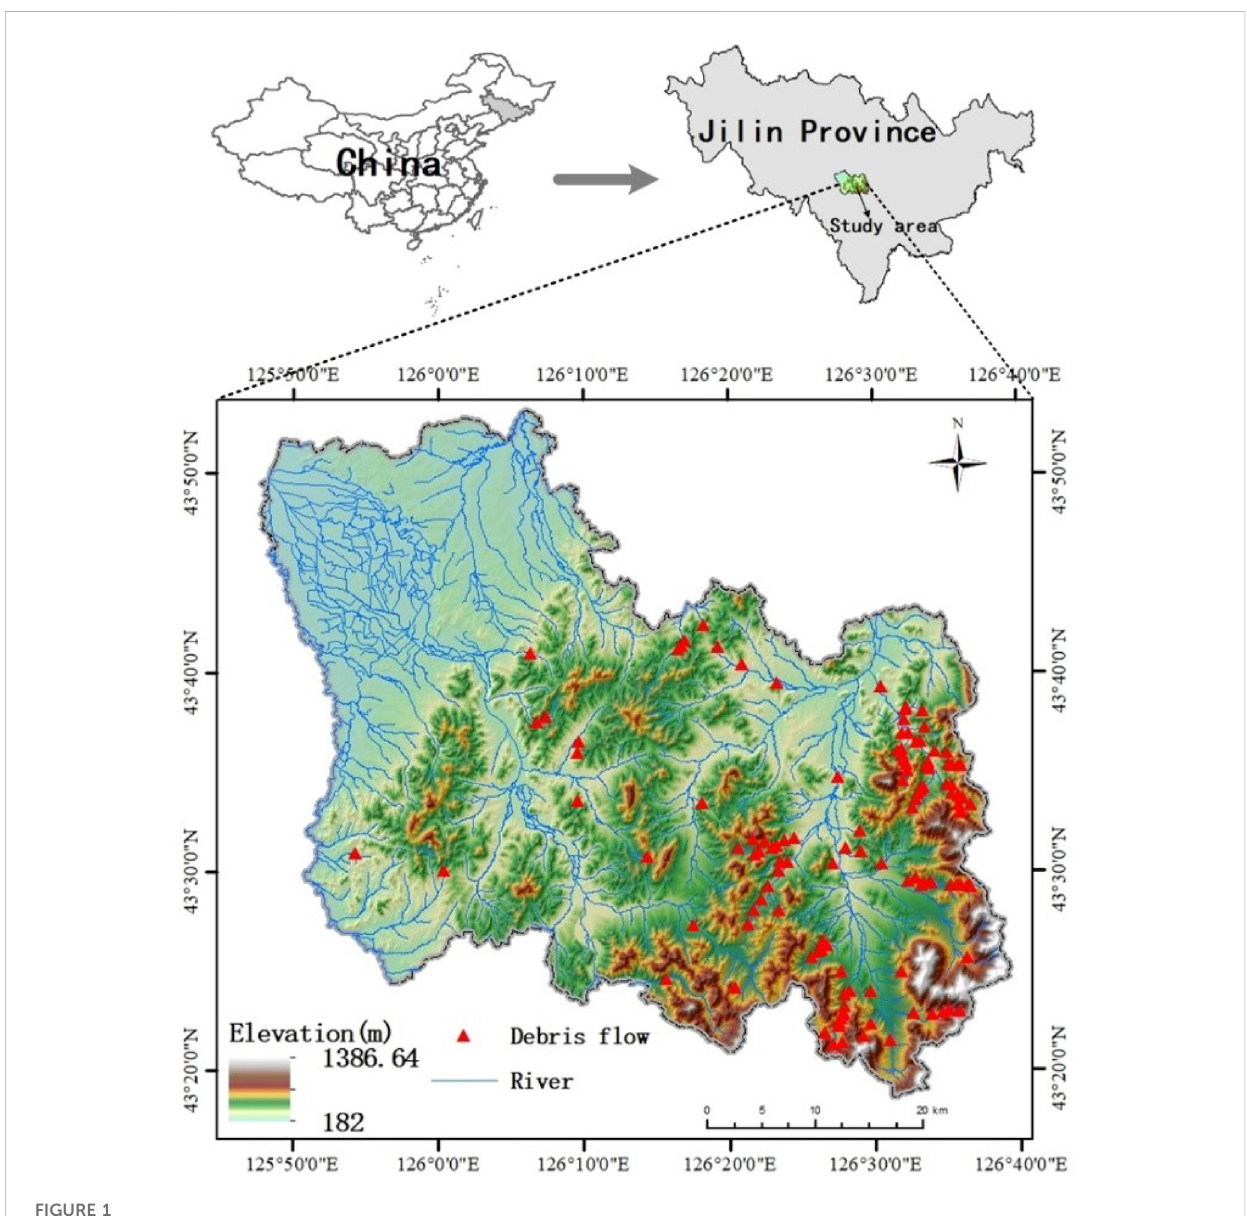
FIGURE 1 The geographic location of the study